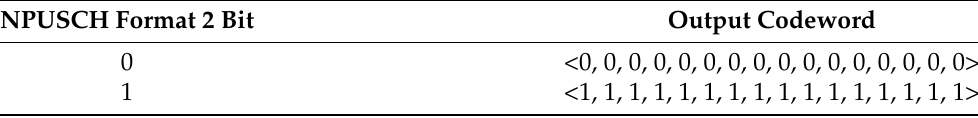
Table 2. Block encoder 1/16.